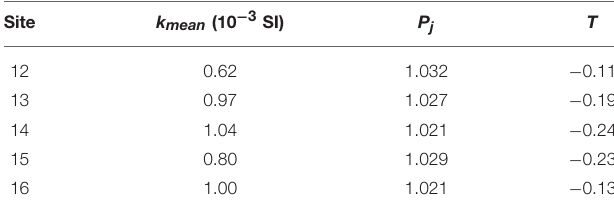
TABLE 4 | Site-mean AMS parameters of A4 member. TABLE 5 | Site-mean AMS parameters of the